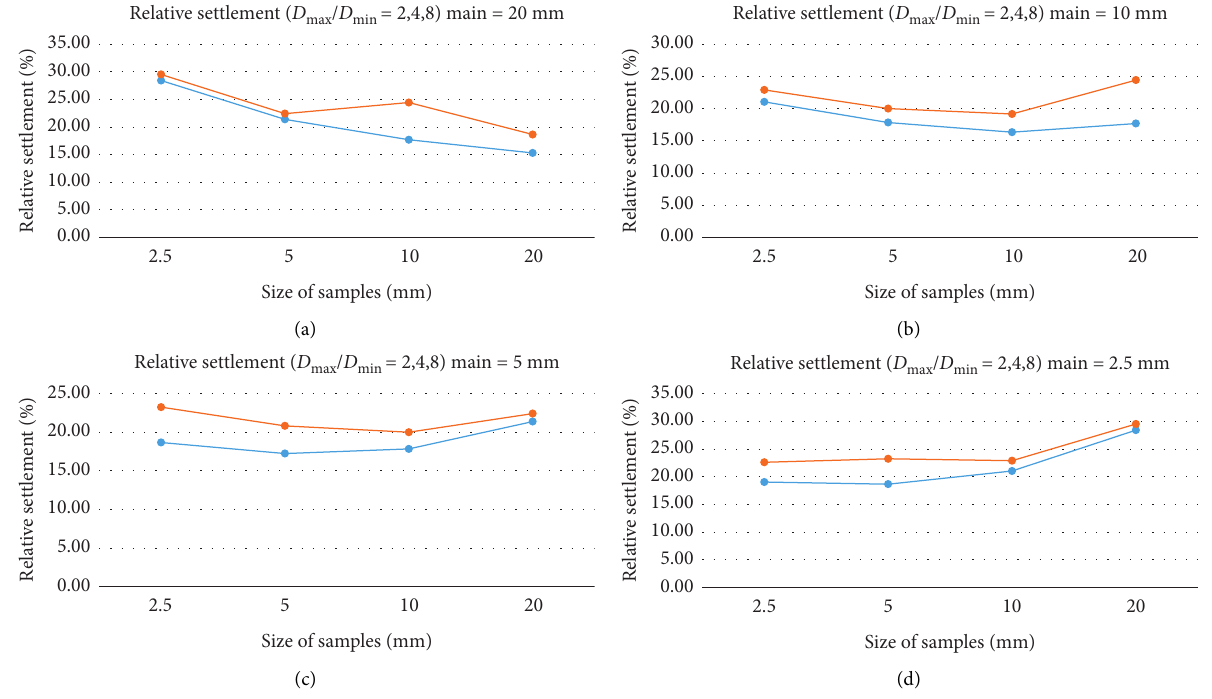
Figure 12: Relative settlement of materials for different granulations by sudden precipitation method (half weight of materials, aggregates with sizes of 2.5, 5, 10, and 20mm).